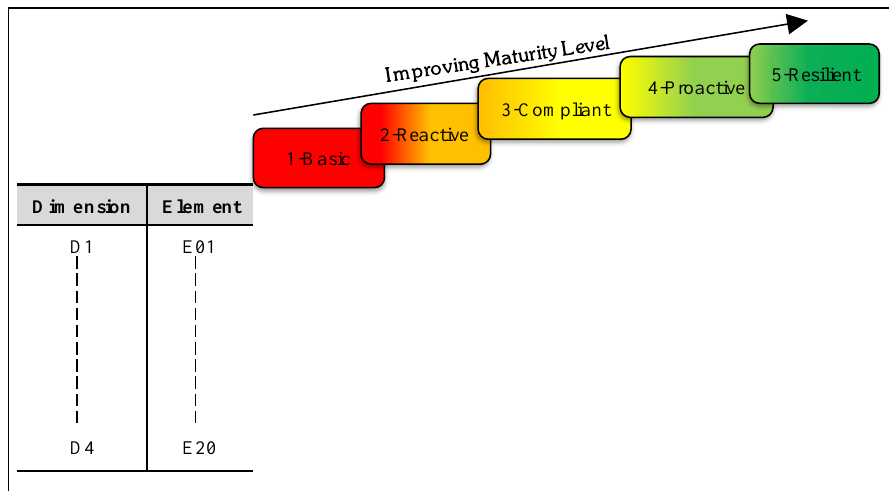
Figure 1. Component of the incident investigations maturity framework.